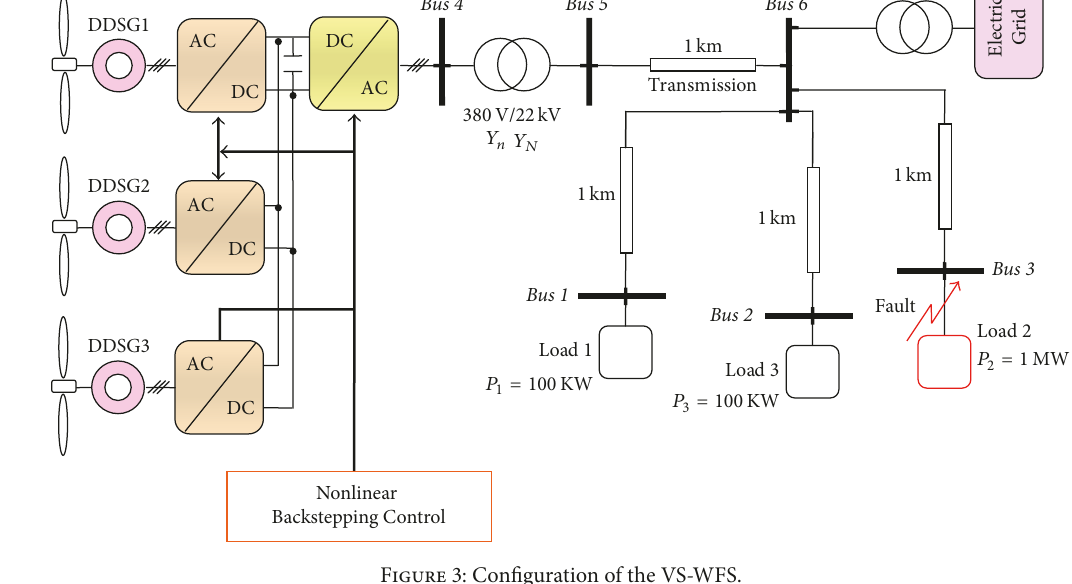
Figure 3: Configuration of the VS-WFS.